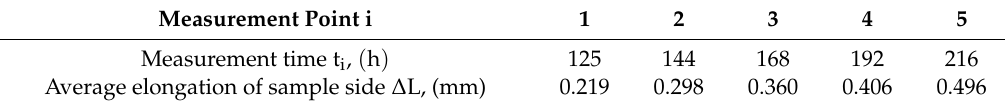
Table 6. Calculation parameters to determine the slope and the intercept in the simple regression